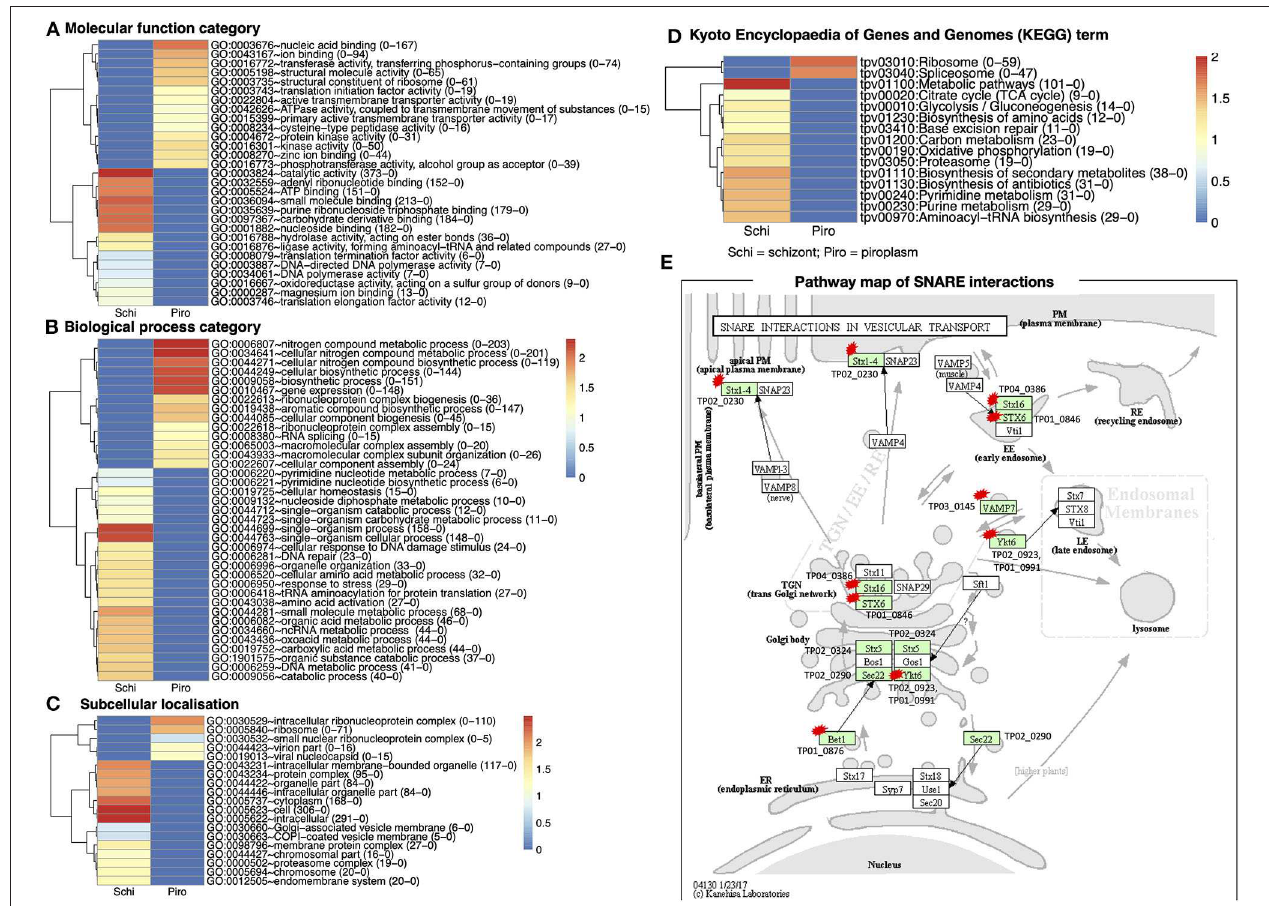
FIGURE 4 | Gene Ontology (GO) functional classification for differentially expressed genes in the two developmental stages studied. (A) Molecular function category. (B) Biological process category. (C) Subcellular localization. (D) Kyoto Encyclopedia of Genes and Genomes (KEGG) database of the categorized genes downregulated in schizont and upregulated piroplasm. Genes without ontology information are not included. The proportion number of each GO and KEGG term of schizont and piroplasm is, respectively, presented in the parentheses in front of the GO and KEGG terms. Red color indicates most enriched (2), and blue, no enrichment (0). The expression level is color coded: red for over-expressed, white for unchanged. (E) Pathway map of SNARE interactions in vesicular transport. This pathway is annotated with most of the hypothetical proteins among all the referred pathways. The arrows in the pathway indicate the molecular interaction or reaction. The green boxes are hyperlinked to identified genes (encoded proteins) involved in the reaction, and the green box with a red star is hyperlinked to the hypothetical proteins involved in the pathway. Schi represents schizont stage, and Piro,